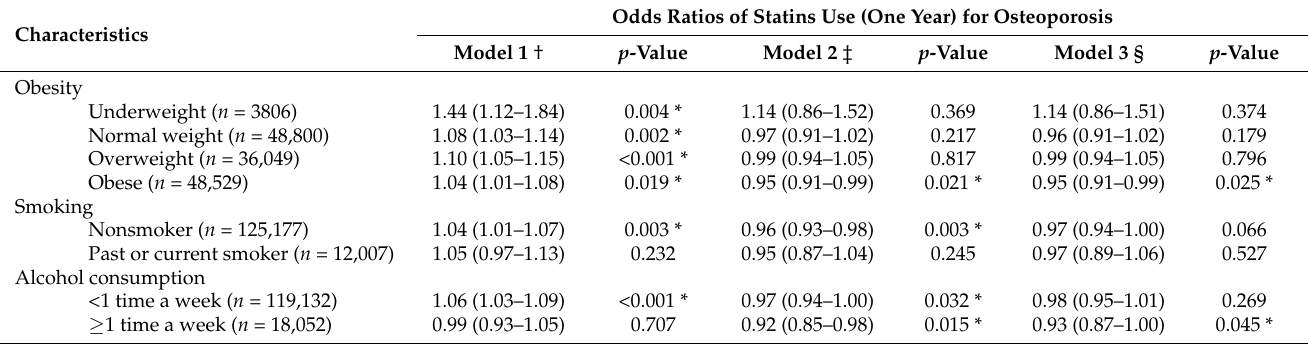
Table 3. Odds ratios (95% confidence interval) of the date of statin use (one year) for osteoporosis in each subgroup according to obesity, smoking, alcohol consumption, total cholesterol, blood pressure, and fasting blood